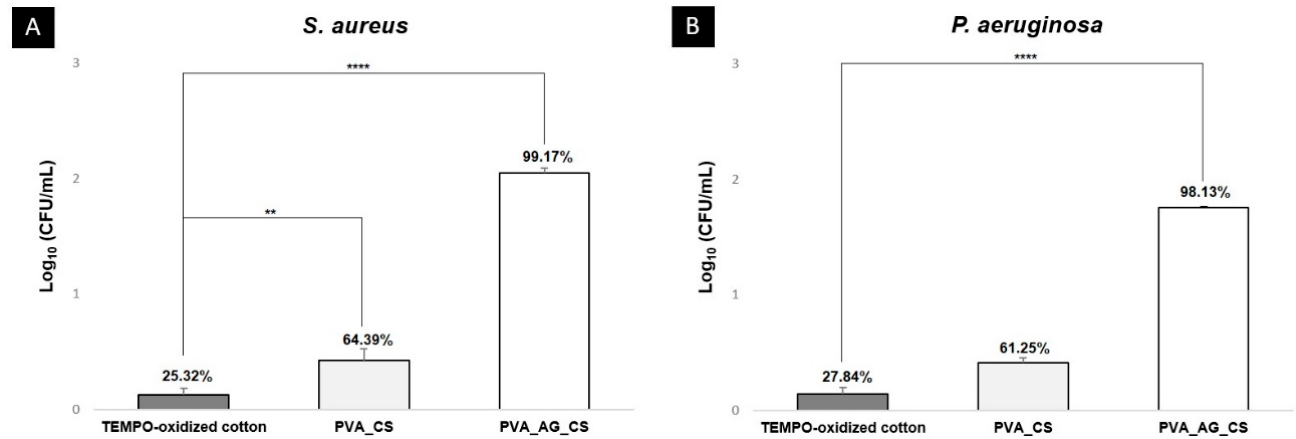
Figure 6. Evaluation of the antibacterial properties of the TEMPO-oxidized cotton, PVA_CS, and PVA_AG_CS nanofibers against S. aureus ( A ); P. aeruginosa ( B ). Data are represented as average ± standard deviation (S.D.), ** p < 0.001 and **** p < 0.0001).